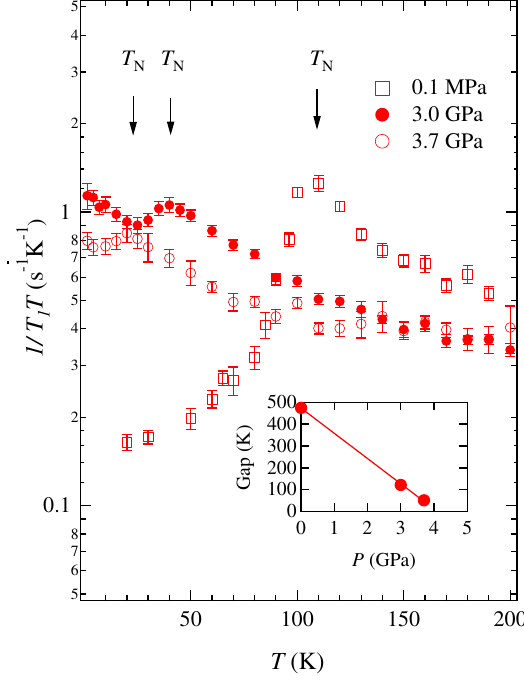
Figure 5: Relaxation rate of 75 As divided by tempera- ture, 1 /T 1 T for LaFeAsO 0 . 4 H 0 . 6 . T N represents the AF transition temperature. The inset shows the pressure dependence of the spin excitation gap ∆ (See Eq.